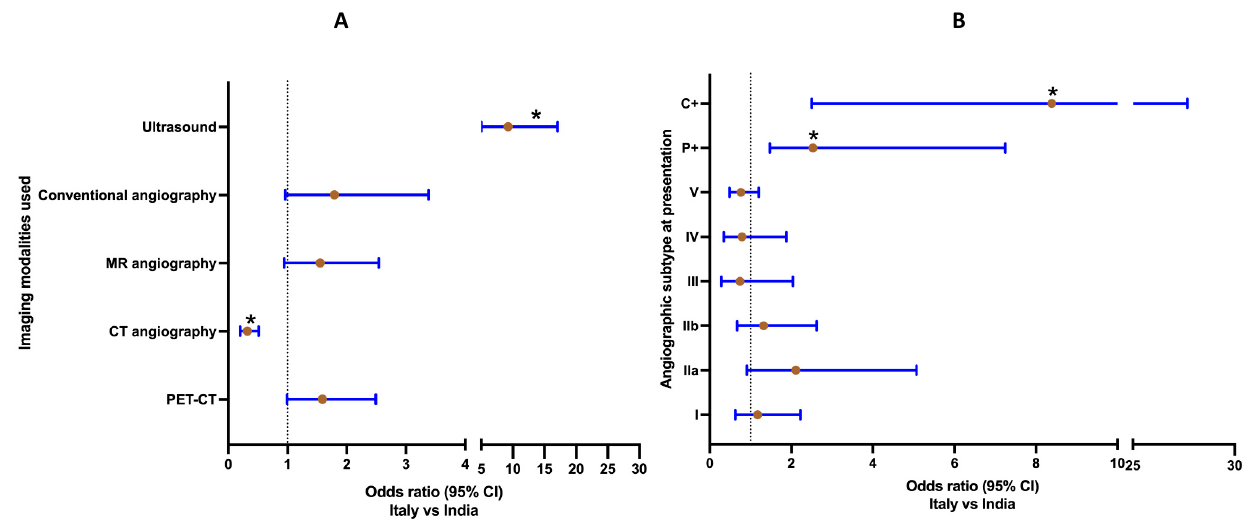
Figure 2. ( A ) Comparison of imaging modalities used at initial assessment in patients with Takayasu arteritis from Italy and India . Odds ratio (95% confidence intervals) presented for odds ratio for imaging modalities used at initial assessment for Italy vs. India (Italy, n = 127; India, n = 191). Those comparisons marked with an asterisk were different between the two cohorts with p < 0.05 after correction for multiple testing. ( B ) Comparison of Hata’s angiographic classification at baseline in patients with Takayasu arteritis from Italy and India . Odds ratio (95% confidence intervals) presented for odds ratio for Hata’s angiographic classification at baseline for Italy vs. India (Italy, n = 127; India, n = 191). Those comparisons marked with an asterisk were different between the two cohorts with p < 0.05 after correction for multiple testing.